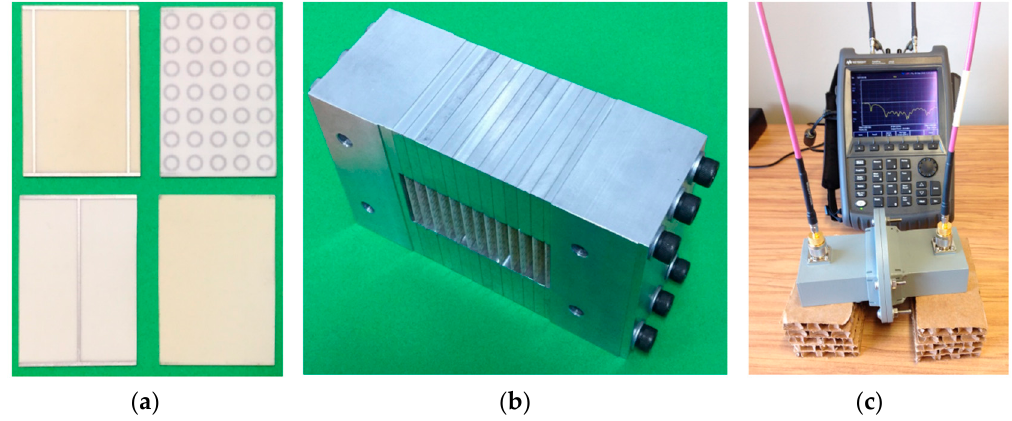
Figure 8. Photo of: ( a ) each PCB type used in the experiment, ( b ) the waveguide PCB mount, and ( c ) measurement equipment shown measuring the through configuration for TL deembedding. (In